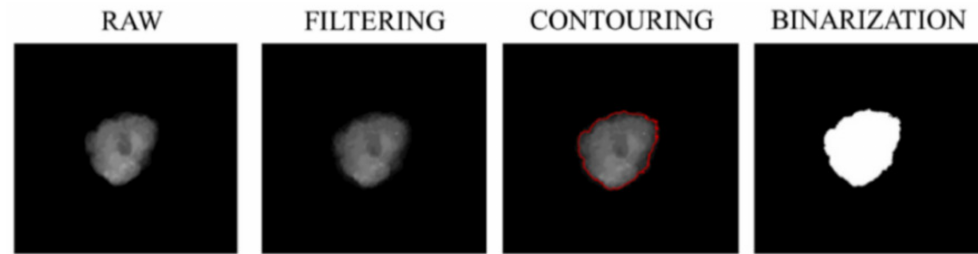
Figure 4. Representation of the main post-processing steps applied to the original